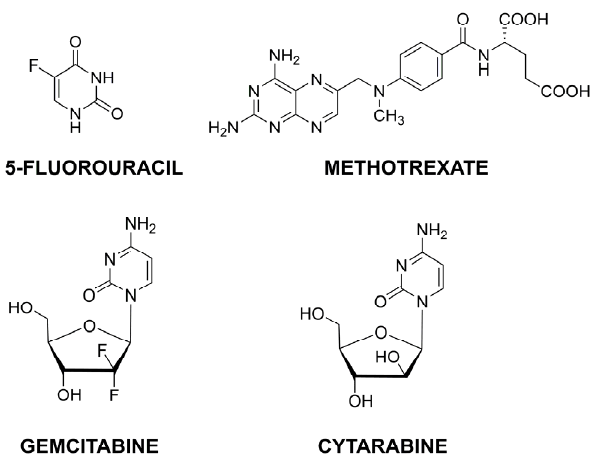
Figure 6. Selected structures of anticancer